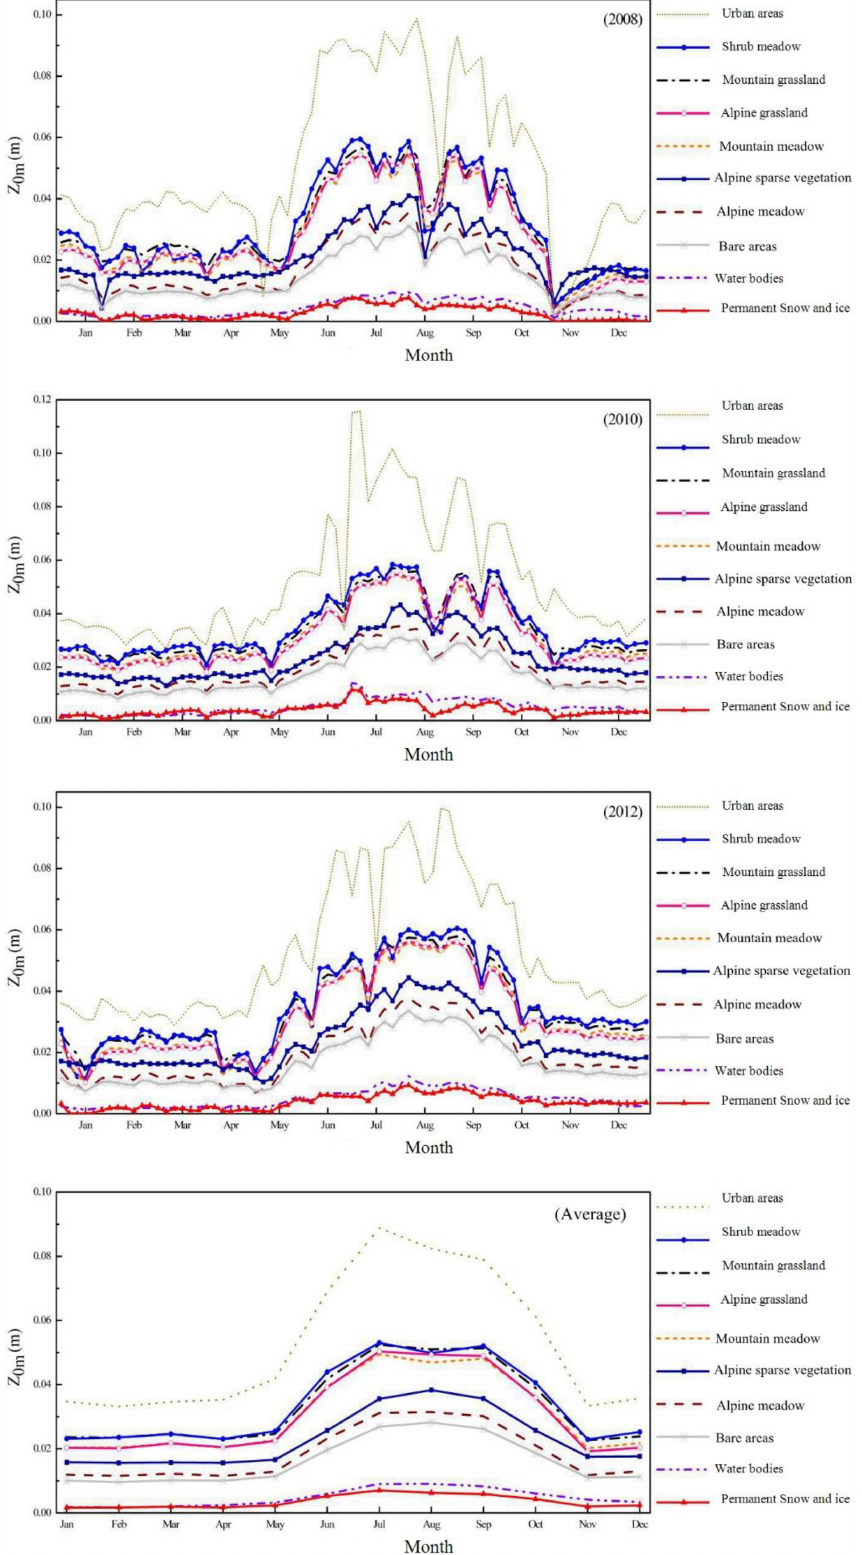
Figure 8. Curve of the surface roughness length for different underlying